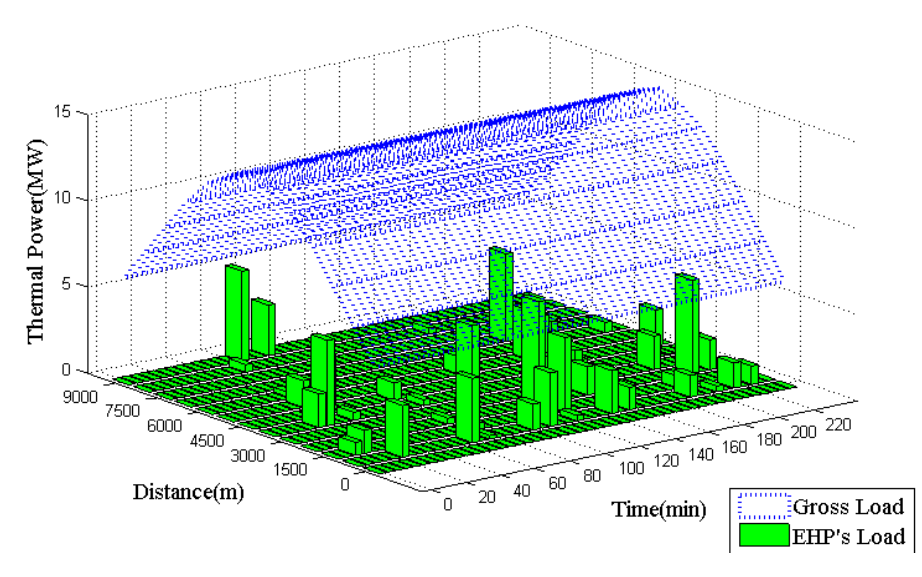
Figure 10. Configuration of Space Heating Load (COP = 2).